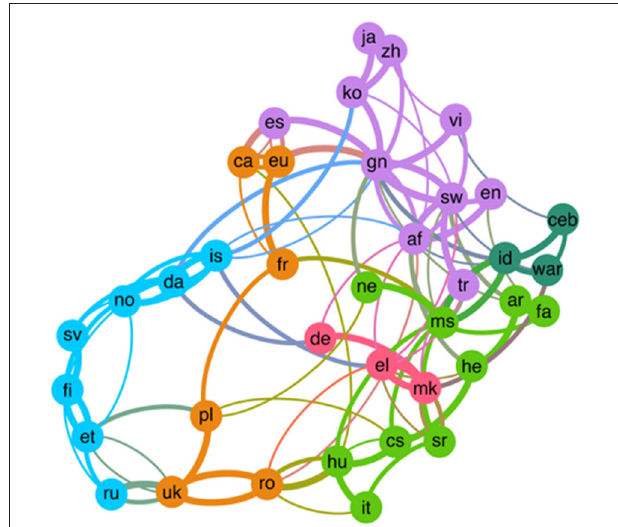
FIGURE 5 | Network graph of language proximity in terms of shared CCC articles. Each node represents a Wikipedia language edition, and has three outgoing links to the three language editions in which its CCC represents the highest percentage of the articles. Links are represented in clockwise direction. Colors represent clusters of language editions identified through the Louvain algorithm for community